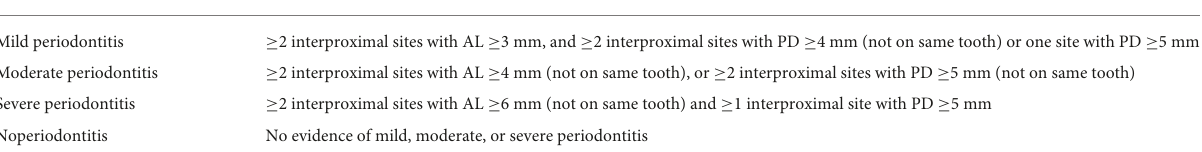
TABLE 1 Periodontitis classification criteria.